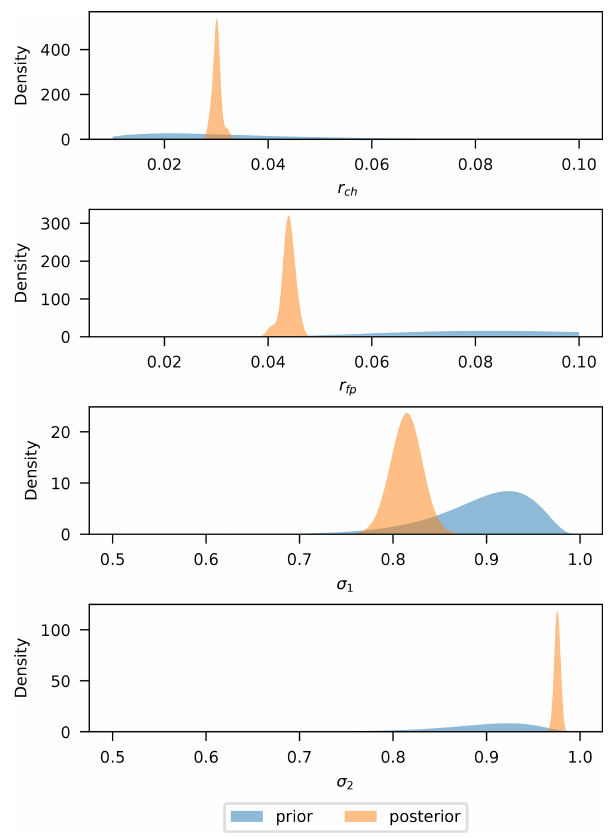
Figure 9. Marginal prior and posterior distribution of parameters for Model 2.